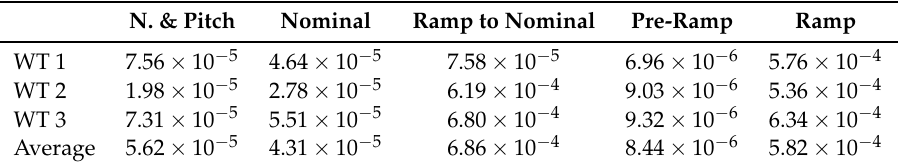
Table 5. Variation of the ORs by WT.